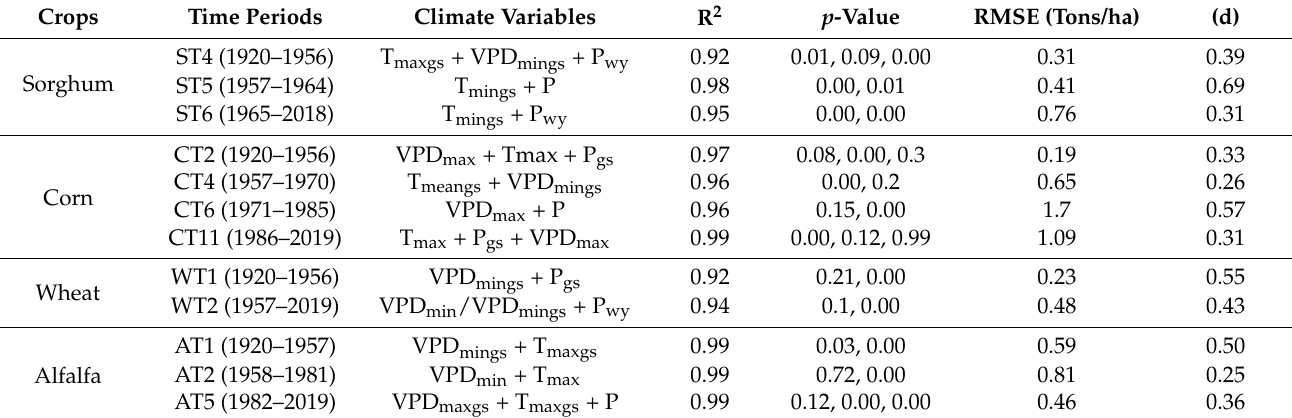
Table 4. The best models based on climate variables only and segmented data periods.